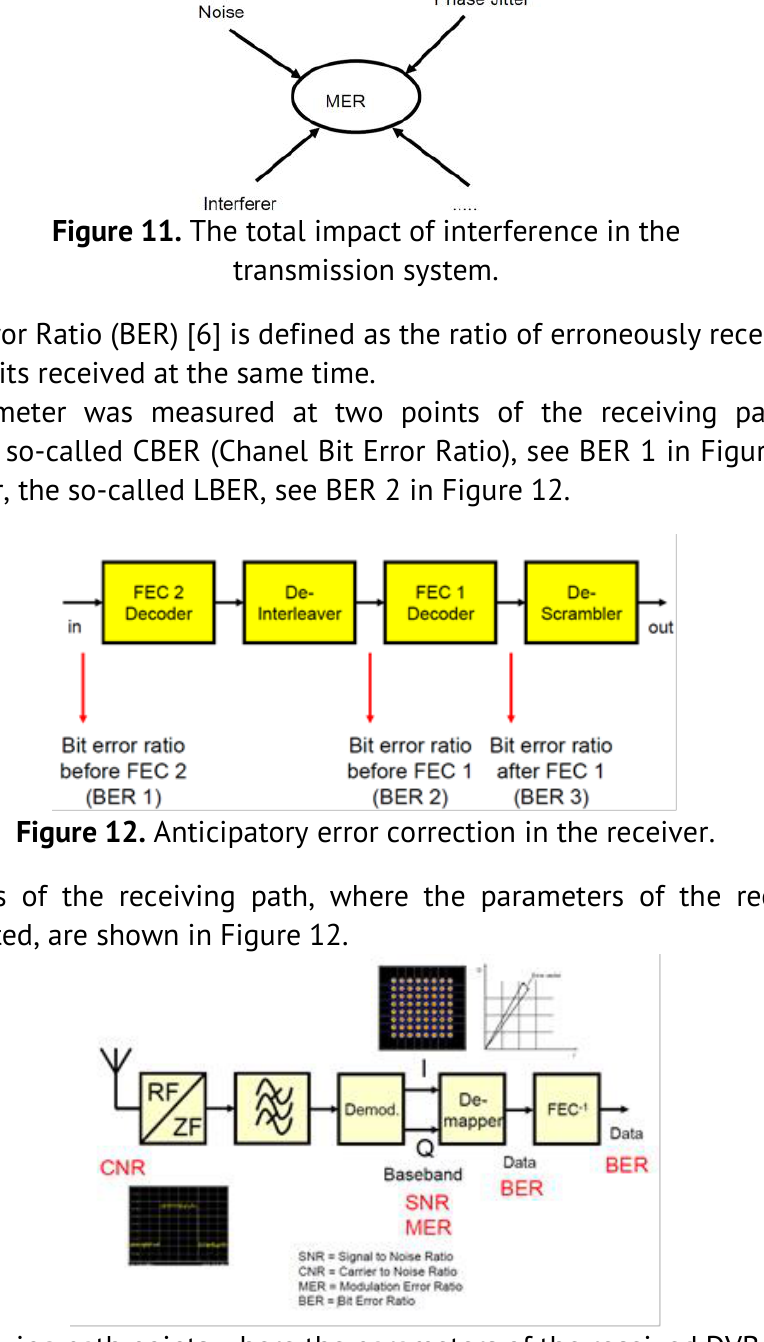
Figure 12. Receiving path points where the parameters of the received DVB-T2 signal are